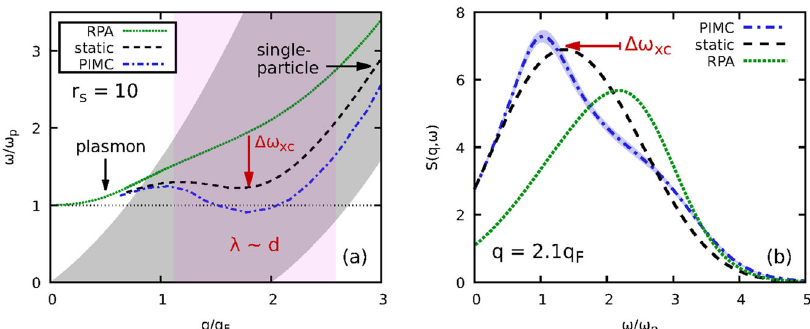
Fig. 1 Spectrum of density fl uctuations of the uniform electron gas. a ω ( q ) at the electronic Fermi temperature ( θ = 1) at r s = 10. Dotted green: random phase approximation; dash-dotted blue: exact path integral Monte Carlo (PIMC) results 20 ; dashed black: static approximation G ( q , ω ) ≈ G ( q , 0). For small wave numbers, the spectrum features a single sharp plasmon excitation. This collective regime, where the wave length λ = 2 π / q is much larger than the average interparticle distance d , λ ≫ d , is well described by the random phase approximation (RPA). Upon entering the pair continuum (shaded grey), S ( q , ω ) becomes substantially broadened. The regime with λ ~ d (shaded red) features a hitherto unexplained pronounced red-shift Δ ω which eventually resembles the roton feature known from ultracold helium 26,27,35 . Finally, the single-particle regime with q ≫ q F and λ ≪ d is dominated by a broad peak with ω ( q ) ~ q 2 . b ω -dependence of S ( q , ω ) at q ≈ 2.1 q F , r s = 10, and θ = 1. The static approximation entails an effective average over the less trivial structure of the full PIMC curve, with the shaded blue area being a measure for the uncertainty in the